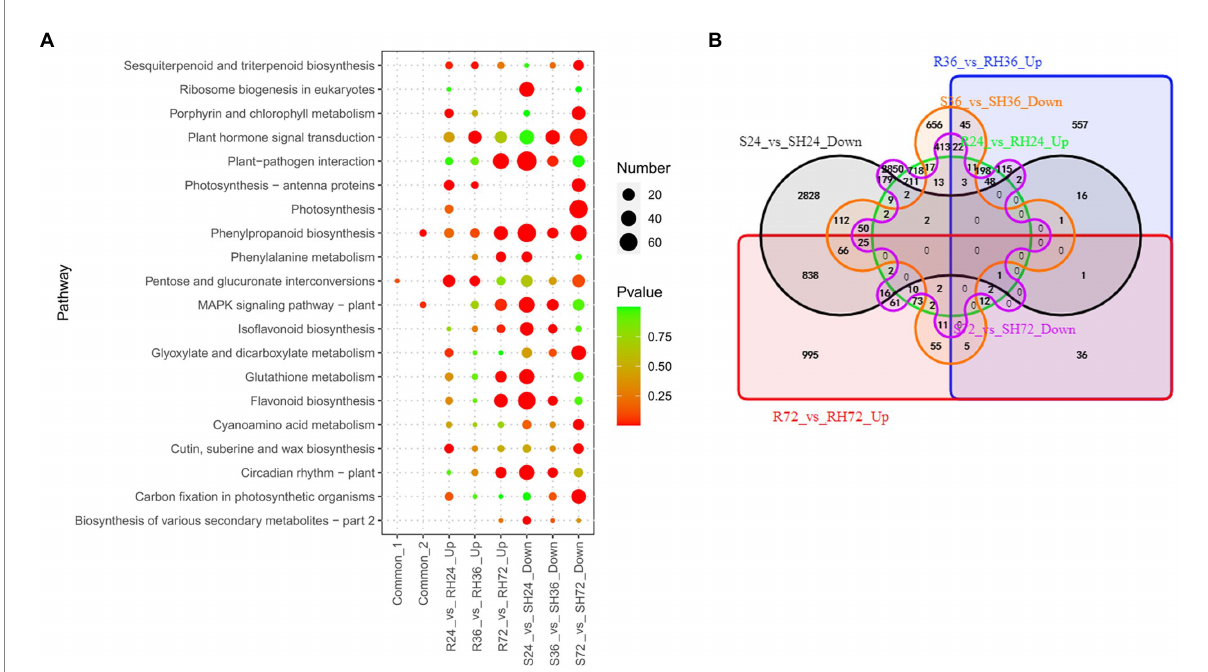
FIGURE 7 Identification of T3Es induced resistance-response DEGs in R24 vs. RH24, R36 vs. RH36, R72 vs. RH72, S24 vs. SH24, S36 vs. SH36, and S72 vs. SH72. (A) KEGG enrichment analysis of common, up-regulated, and down-regulated DEGs in each treatment comparison. Common-1 indicates the common up-regulated DEGs in R24 vs. RH24, R36 vs. RH36, and R72 vs. RH72. Common-2 is the common down-regulated DEGs in S24 vs. SH24, S36 vs. SH36, and S72 vs. SH72. (B) A big Venn diagram of DEGs for up-regulated DEGs in Rs vs. RHs and down-regulated DEGs in Ss vs.